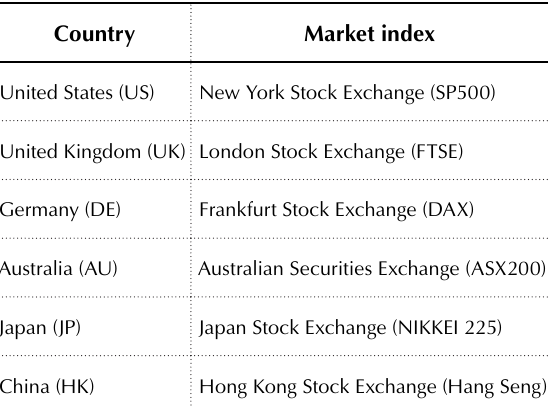
Table 1. List of countries and market indices in the study